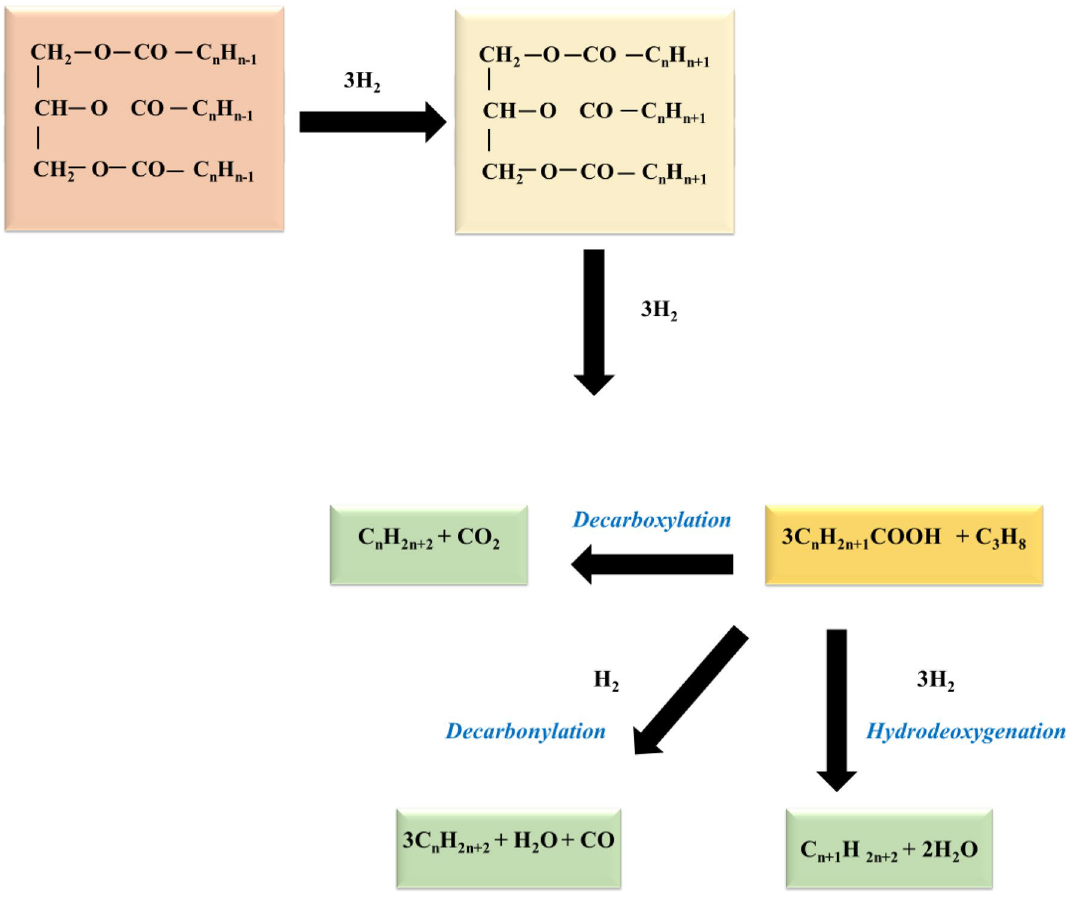
Figure 1. Hydro-conversion of a